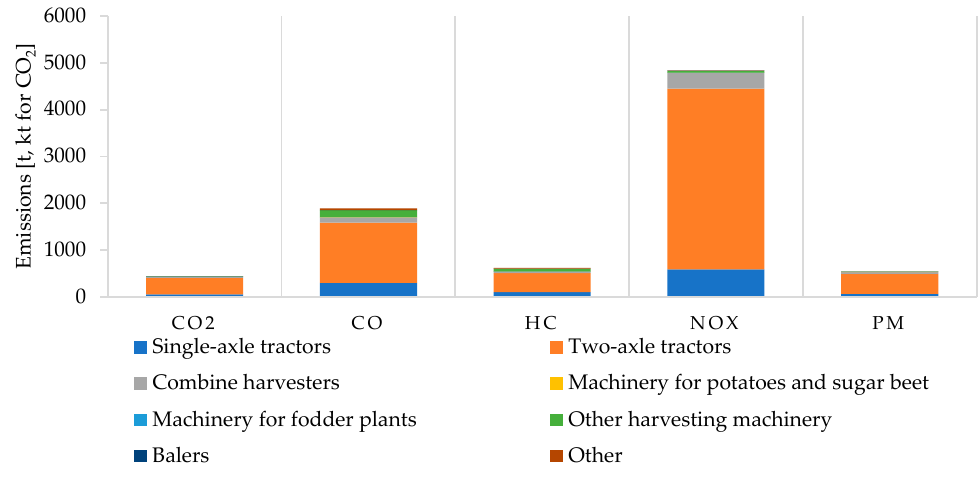
Figure 4. Emissions for all machinery categories by emission type.